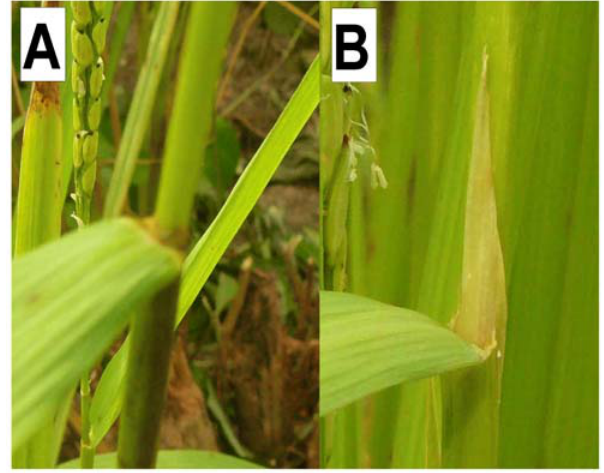
Figure 4. Main ligule shapes found in this study. Ligule shape of O. glaberrima (A: small, rounded) and O. sativa and interspecific hybrids from cluster 4 (B: long, pointed). doi:10.1371/journal.pone.0007335.g004 PLoS ONE |